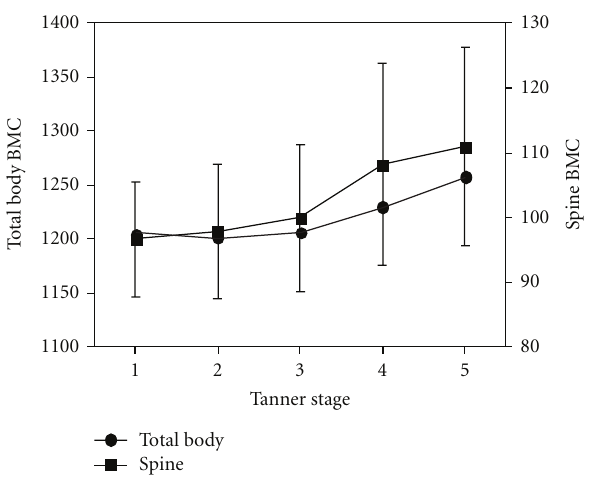
Figure 2: This diagram illustrates changes in Total Body (black circle) and Spine (black square) Bone Mineral Content (BMC) adjusted for body size in a population-based cohort of adolescents (mean 11.8 years old) by Tanner Stages on the X -axis. It is drawn from data in Table 3 [28]. Endocrine Society permission provided.